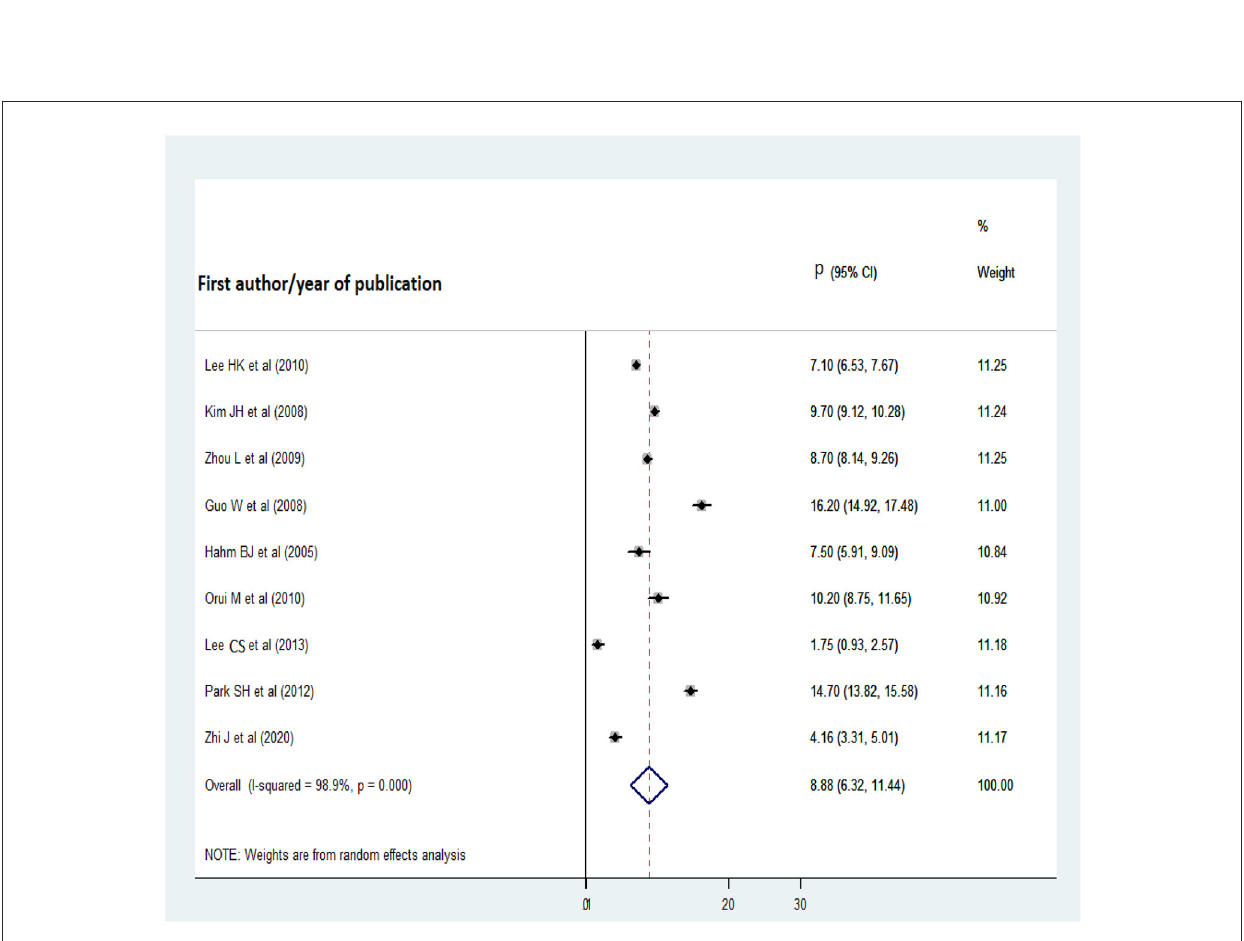
FIGURE3 Forest plot of the 1-year pooled prevalence of